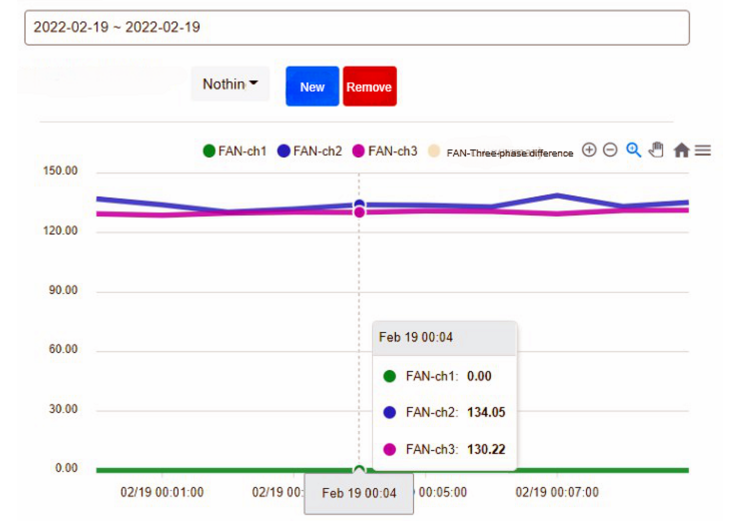
Figure 7. History of three current